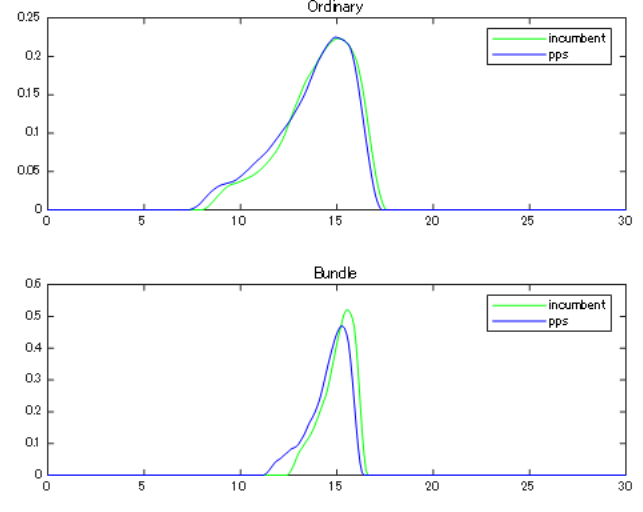
Figure 2. Cost densities of incumbent and PPS